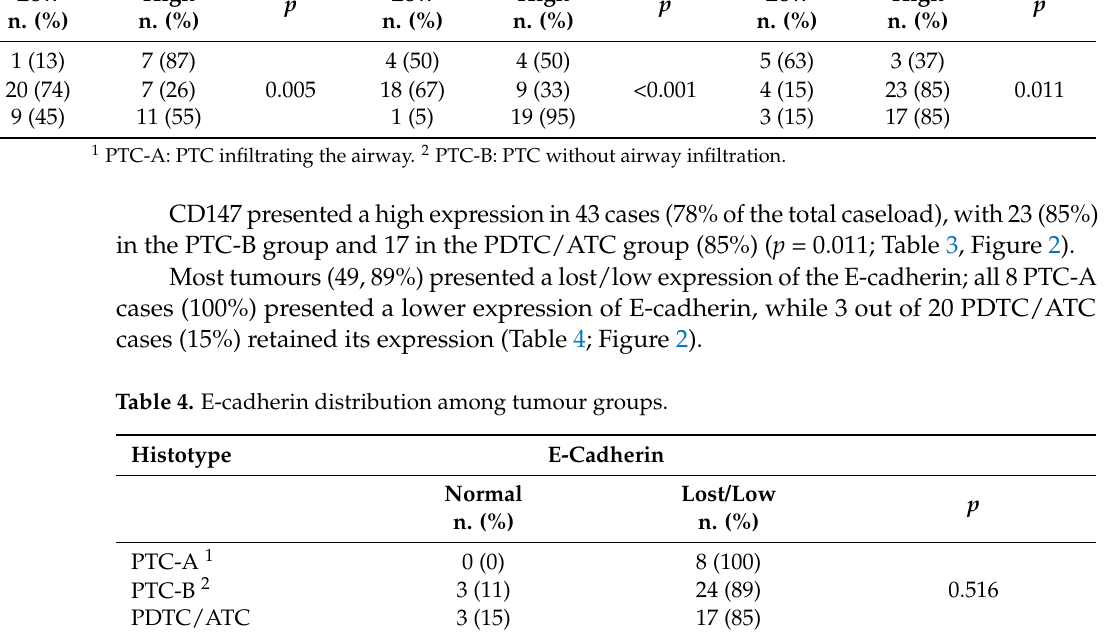
Figure 2. Biomarker immunohistochemical expression. ( a ) Membranous high expression of N-cadherin on tumour cells of PTC infiltrating the airway (PTC-A) compared with ( b ) an intrathyroid PTC (PTC-B); ( c ) PTC-A presented a low Table 3. N-cadherin, AhR and CD147 expression among tumour groups. expression of E-cadherin and ( d ) PTC-B (follicular variant) with retained expression of this molecule; ( e ) PTC-A showing a high expression of AhR in contrast with ( f ), which shows low expression of the same immunomarker in a PTC-B; ( g ) CD147 high expression of PTC-B and ( h ) absent expression in PTC-A. Original magnification: ( a – d , h ) 200X; ( e – g ) 400X.